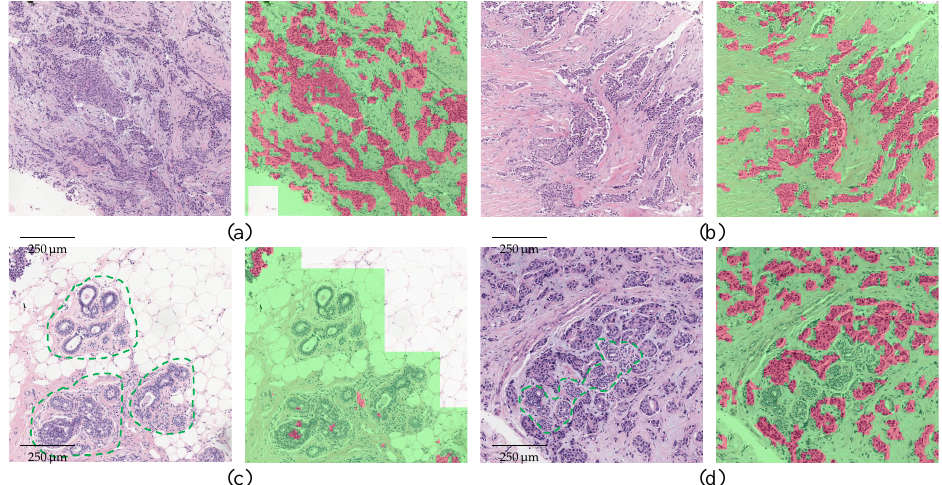
Figure 8. Segmentation results of some ROIs. ( a , b ) Examples of invasive tumor. ( c ) An example of lobules (a normal structure in breast tissue). ( d ) An example of lobules surrounded by the invasive tumor. Lobules in ( c , d ) are outlined by green dashed polygons.